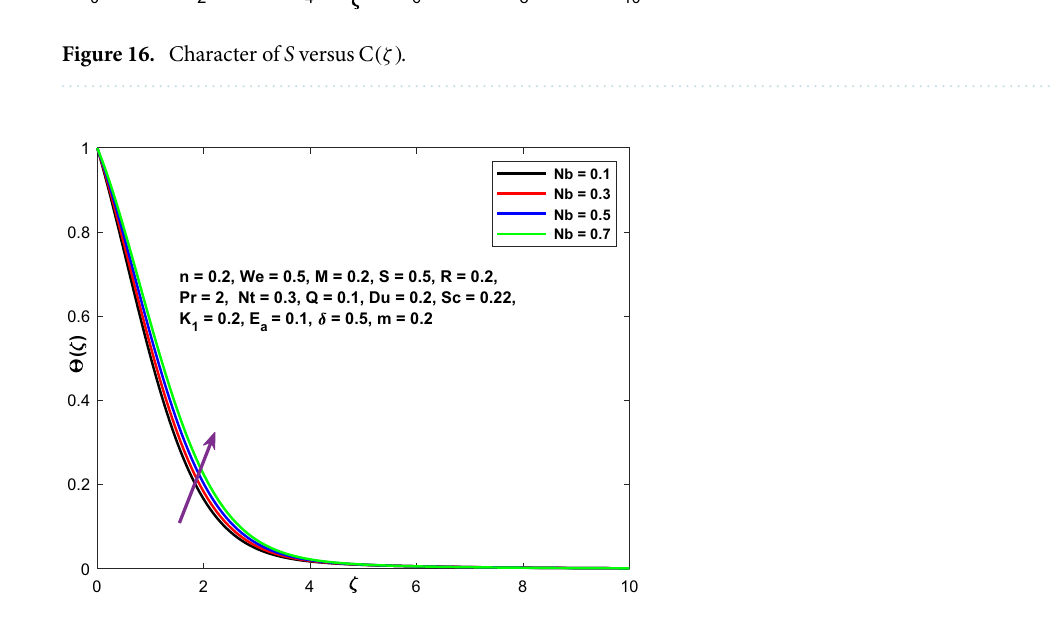
Figure 17. Character of Nb versus �(ζ)